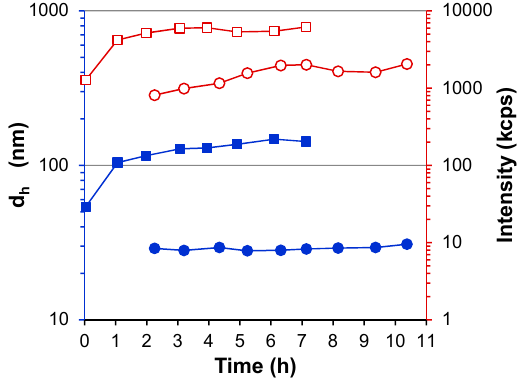
Figure 4. Time-dependent change in the mean hydrodynamic diameter ( d h , nm) of S-PDMAEMA 60 particles prepared at pH 6.8 using feed ratio of 1:1 SS/PDMAEMA (10 mM SS, filled blue circles ● ) and of 2:1 SS/PDMAEMA (20 mM SS, filled blue squares ■ ) presented as a function of time (h). Here the concentration of DMAEMA repeating units is 10 mM and the polymer concentration is 1.57 g/L. Light scattering intensity (I, kcps) is shown as open red symbols of corresponding shape ( ○ and □ ). Data obtained at a 173 ° scattering angle using the Zetasizer instrument.